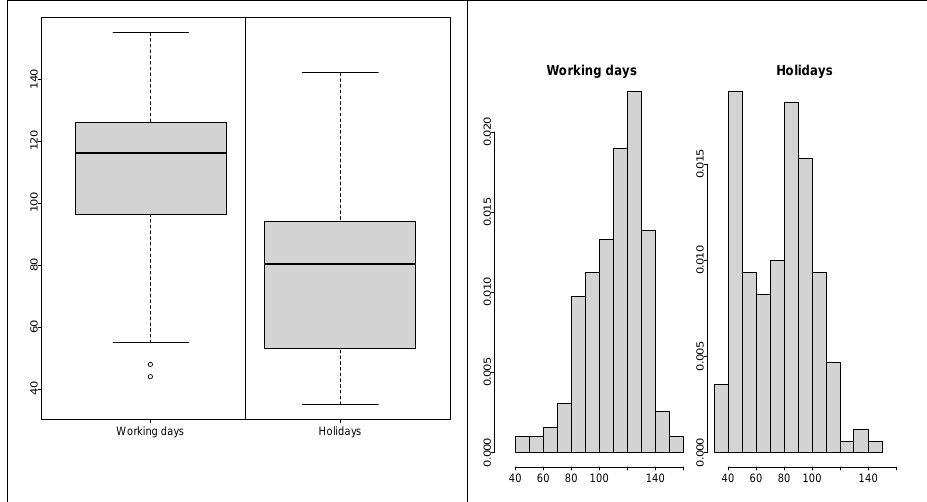
Figure 1. Box-plot (left panel) and histogram (right panel) of daily inpatient activity.